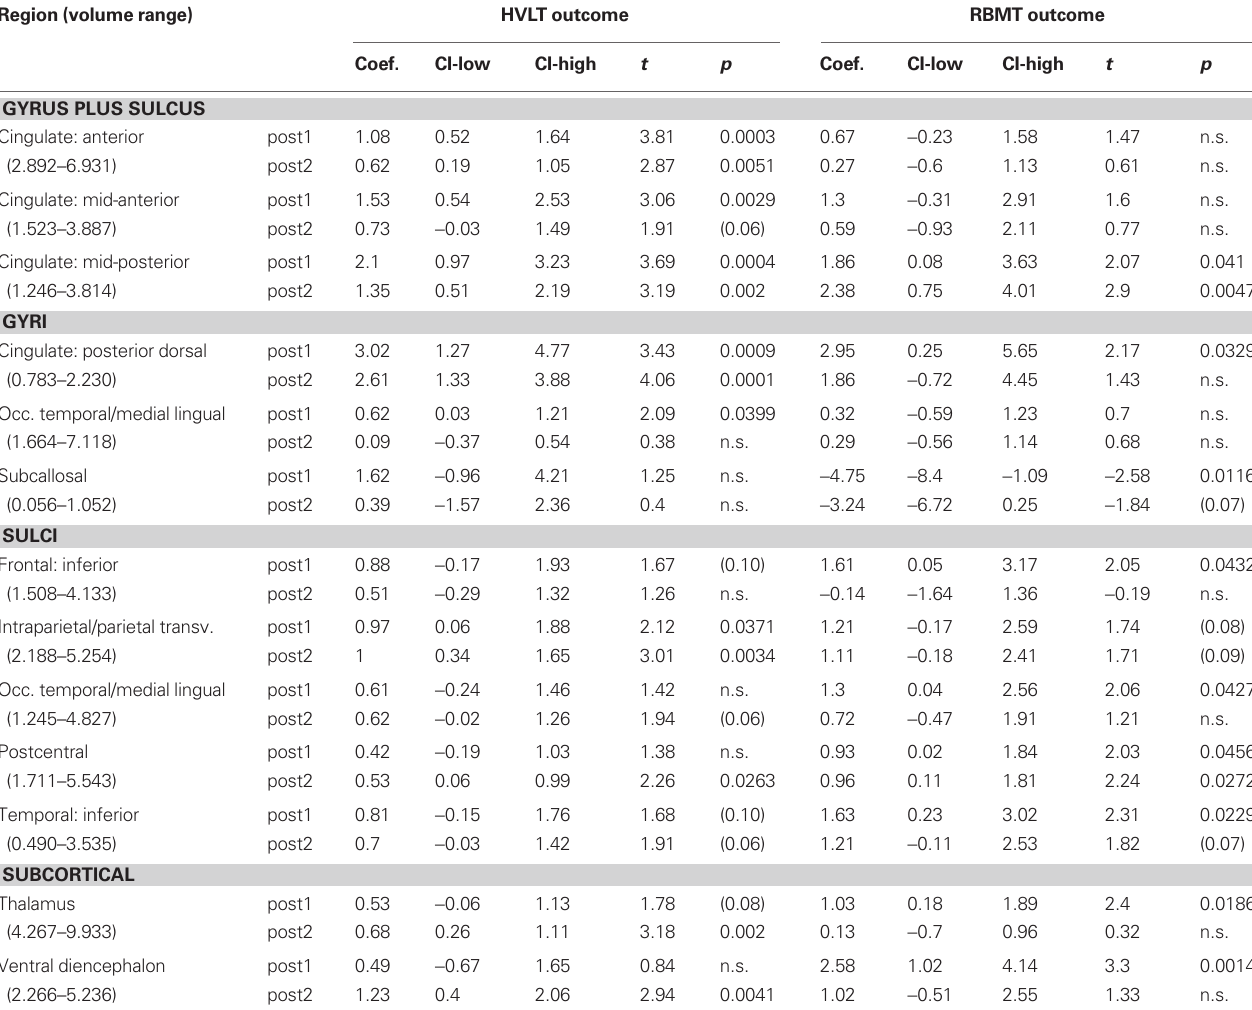
Table 6 | Prediction results for the regional volume term in the brain-wide exploratory analysis. region (volume